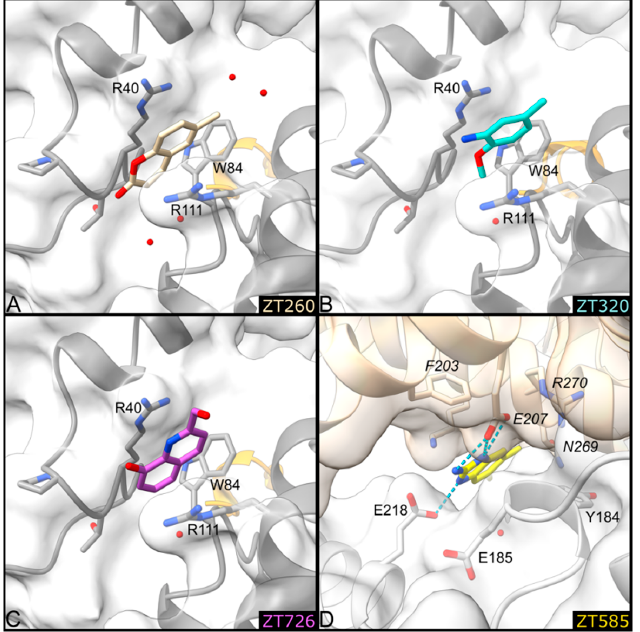
Figure 7. Detailed representation of binding of ZT260 ( A ), ZT320 ( B ), ZT726 ( C ), and ZT585 ( D ) at the protein surface. The protein is represented as a ribbon, the side chains of residues involved in ligand biding are shown as sticks and labelled, water molecules as red spheres, and hydrogen bonds as blue dotted lines. Residues 148–151 forming helix η 1 are coloured orange. In D, the symmetry-related molecule is represented in beige and labelled in